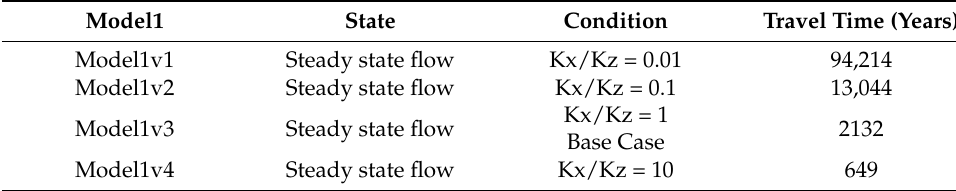
Table 7. Sensitivity analysis for anisotropy of the entire model.